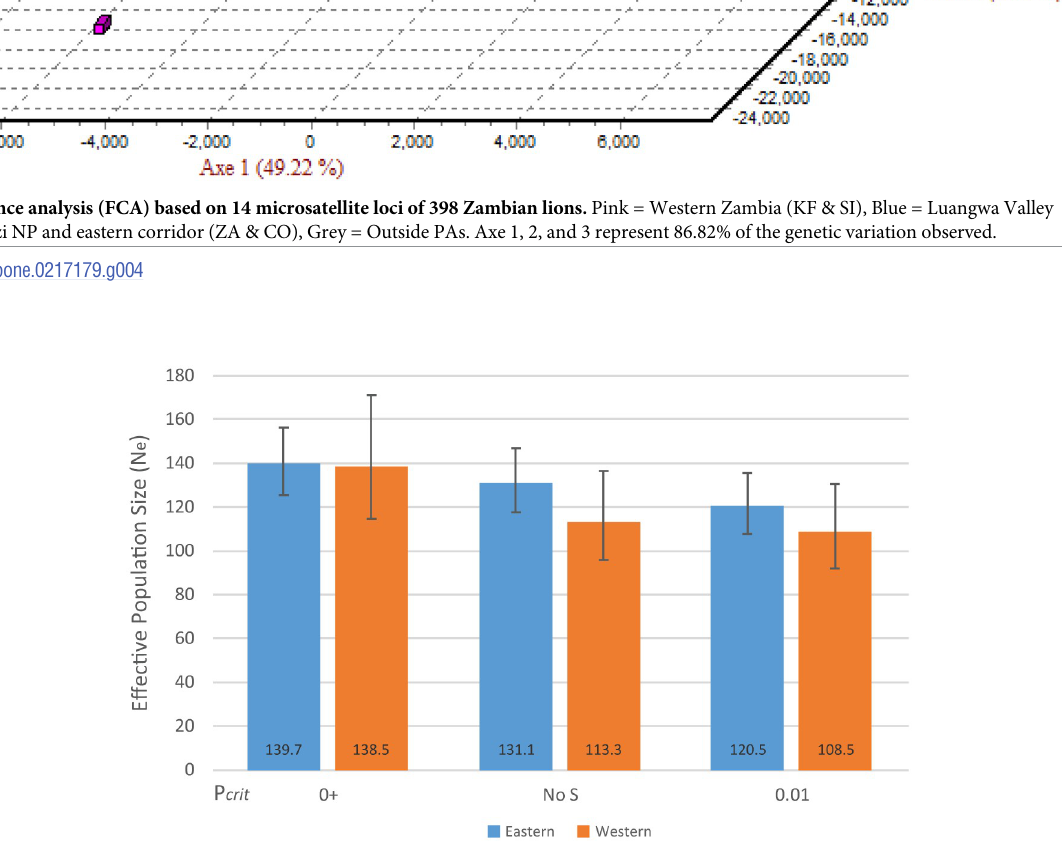
PLOS ONE | https://doi.org/10.1371/journal.pone.0217179 May 31,